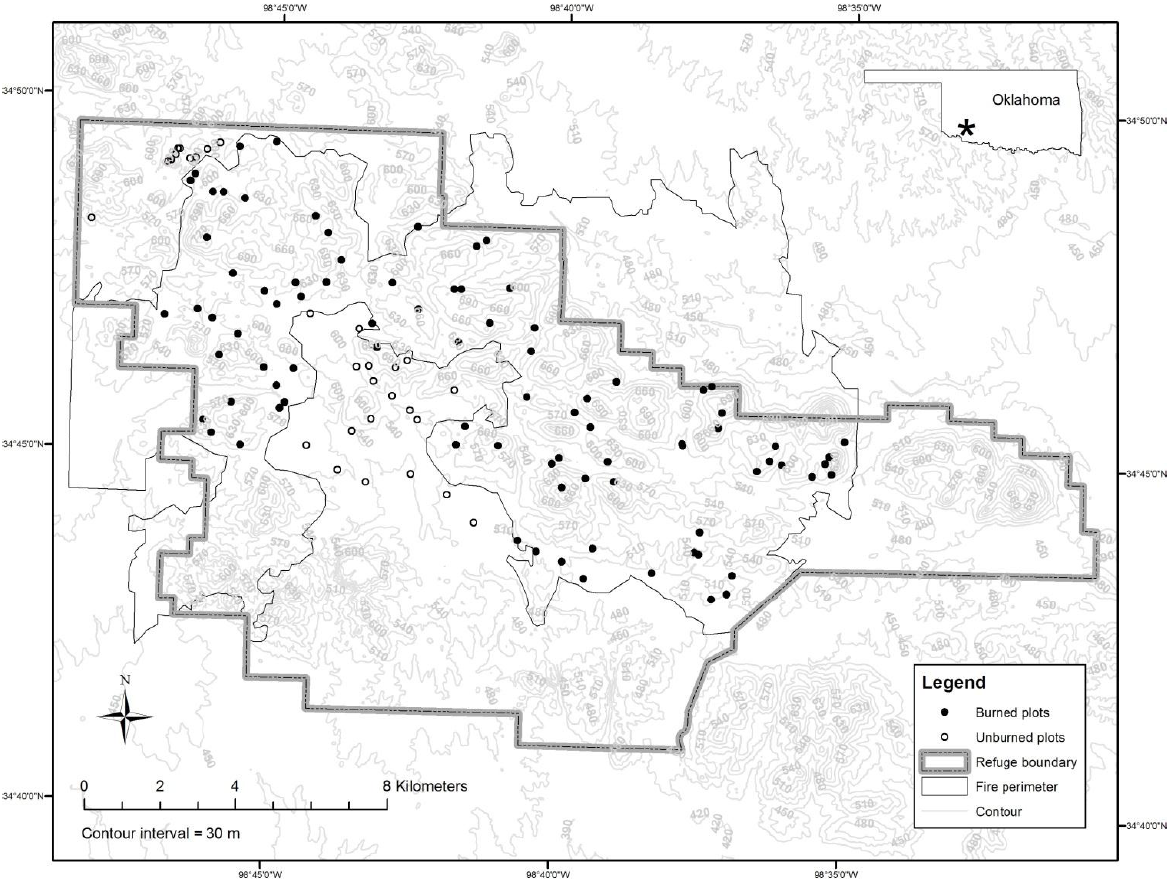
Figure 1. Topographic map of the Wichita Mountains Wildlife Refuge (WMWR) showing the perimeter of the Ferguson Fire and locations of plots used to measure post-fire vegetation and burn severity. Asterisk on inset map of Oklahoma indicates location of the study